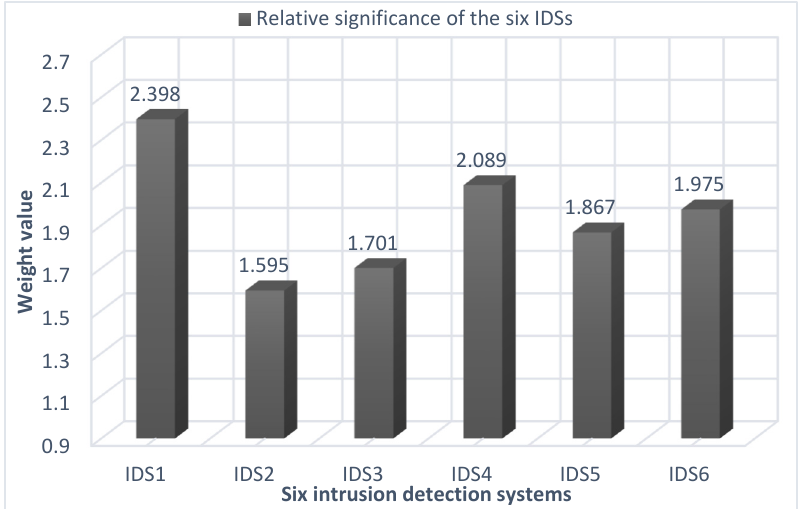
Table 17. Comparative analysis with other approach for ranking the IDSs.